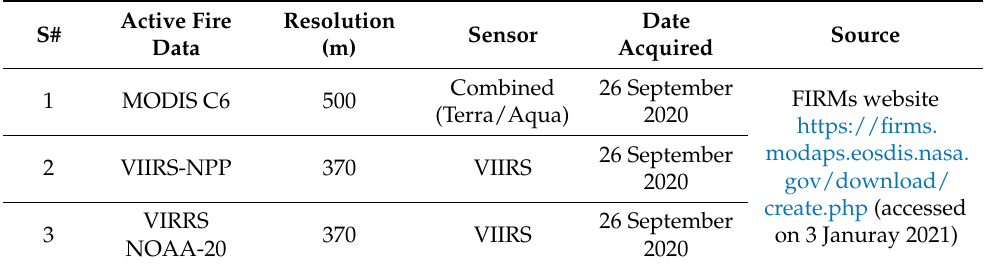
Table 3. Active fire dataset, its characteristics, and date and source of